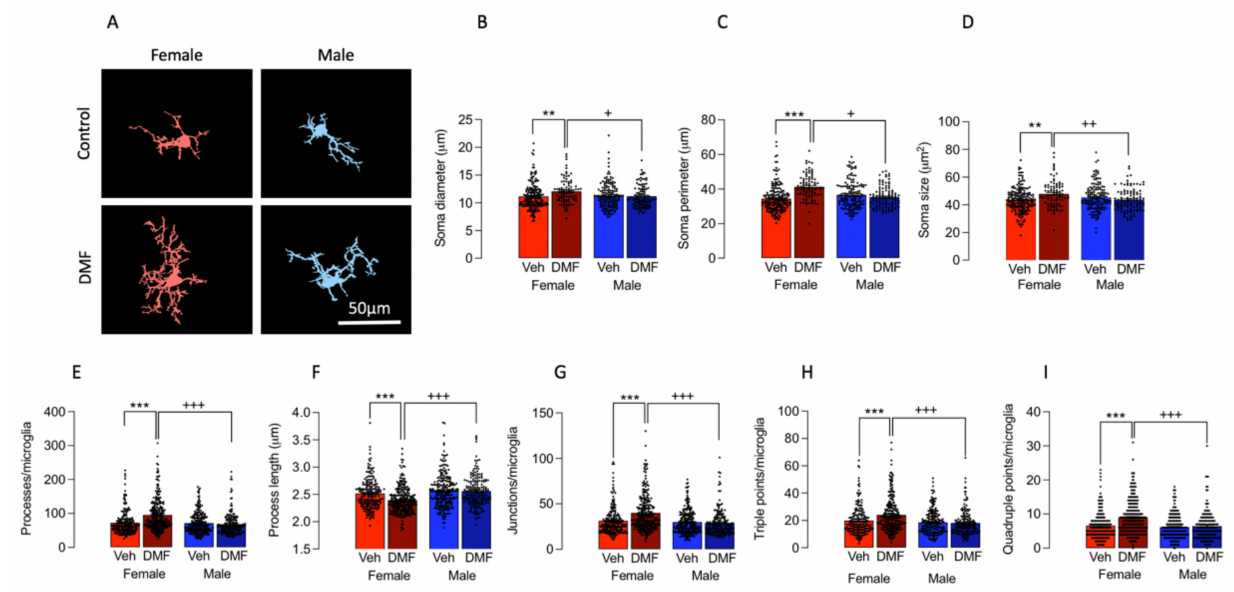
Figure 2. DMF impacts on microglial morphology in a sex-dependent manner. ( A ) Masks were prepared for analysis of morphological features of microglia. Scale bar = 50 µ m. ( B – D )